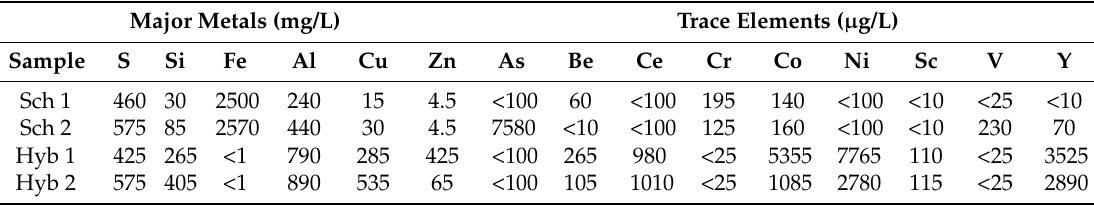
Table 3. Element concentrations measured in the ammonium oxalate solution at the end of the dissolution